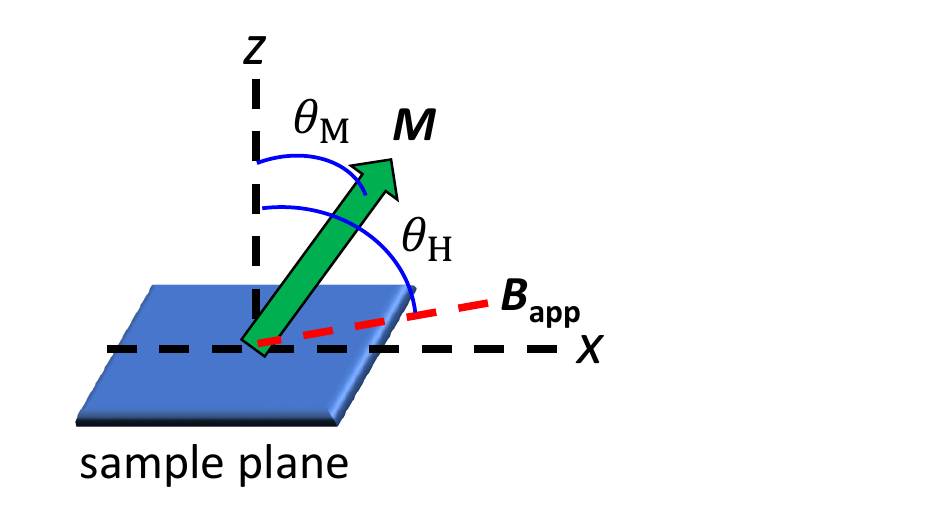
Figure 2. Angle definition for AHE measurements. The normal to the sample plane is defined as the z axis. When a magnetic field (B app ) is applied at the angle of θ H with respect to the z axis, the magnetization ( M ) tilts at an angle of θ M , which is determined by the balance between the uniaxial anisotropy energy and Zeeman